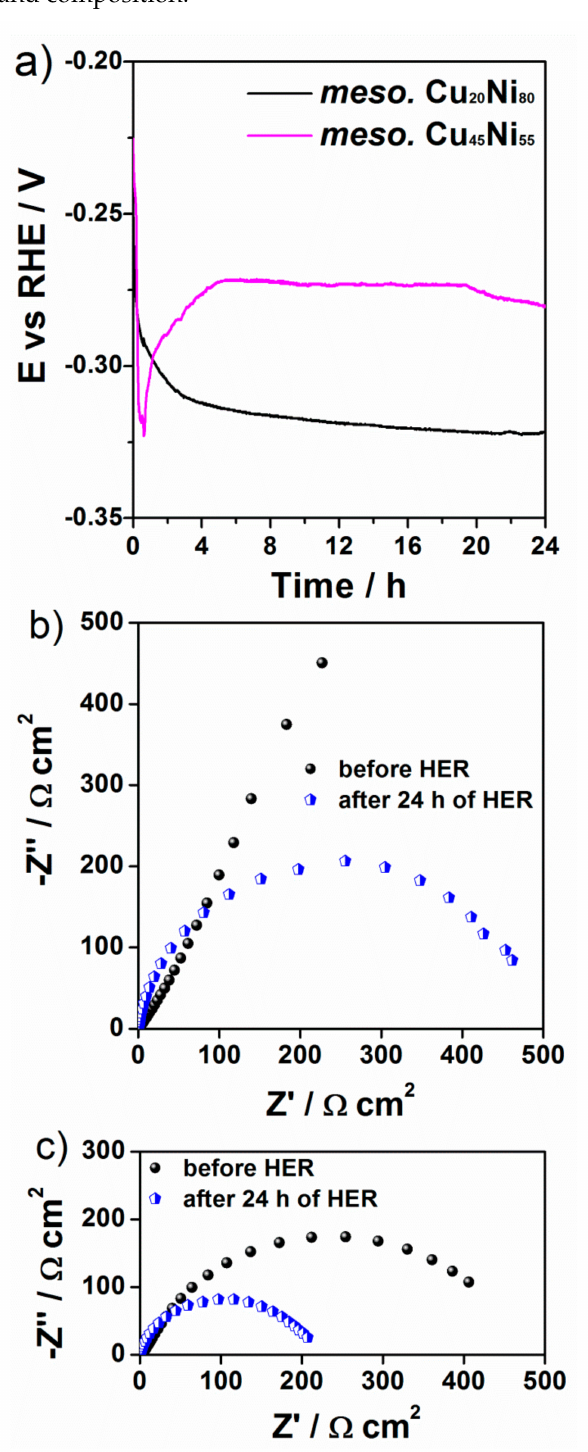
Figure 10. Potential as a function of time during galvanostatic HER at − 10 mA · cm − 2 for surface- mesostructured CuNi films ( a ). Nyquist plots before and after 24 h durability tests for surface- mesostructured films with composition ( b ) Cu 20 Ni 80 and ( c ) Cu 45 Ni 55